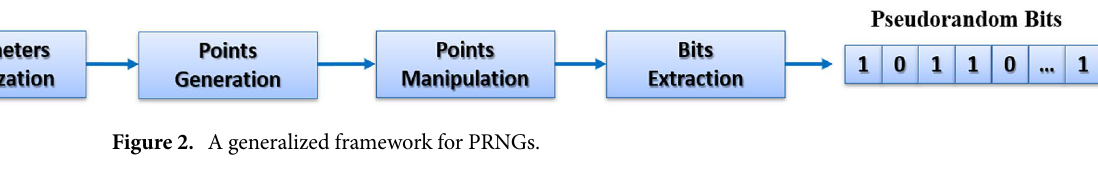
Figure 2. A generalized framework for